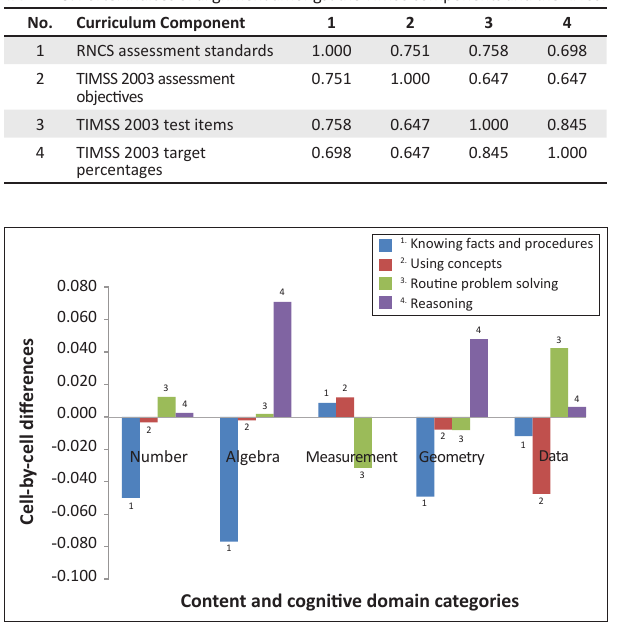
FIGURE 2 : Discrepancies between RNCS assessment standards and the 2003 TIMSS assessment objectives.